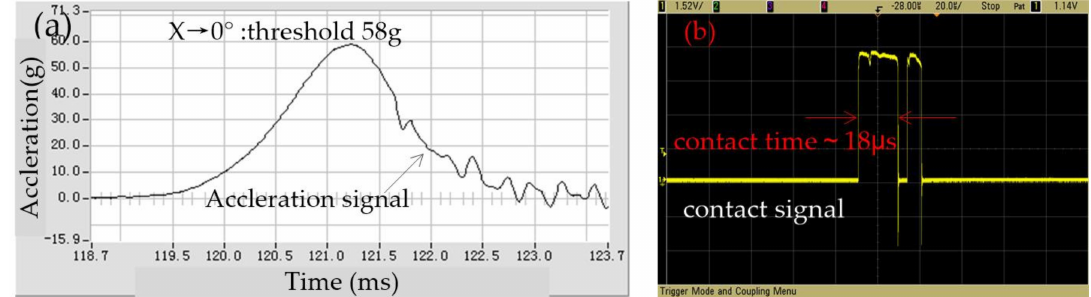
Figure 9. The tested threshold in the x direction.